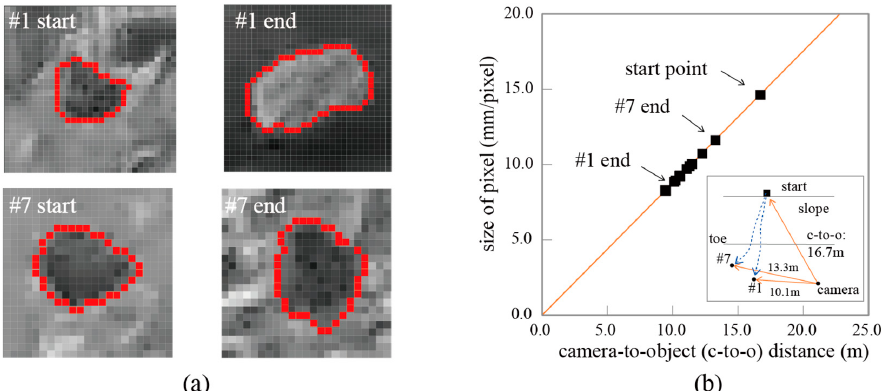
Figure 4. Variation in object size through rockfall test in this study: ( a ) clipped images of the rocks at start and end points of test #1, test #7 and bounded edges with red color; ( b ) pixel size as a function of camera-to-object